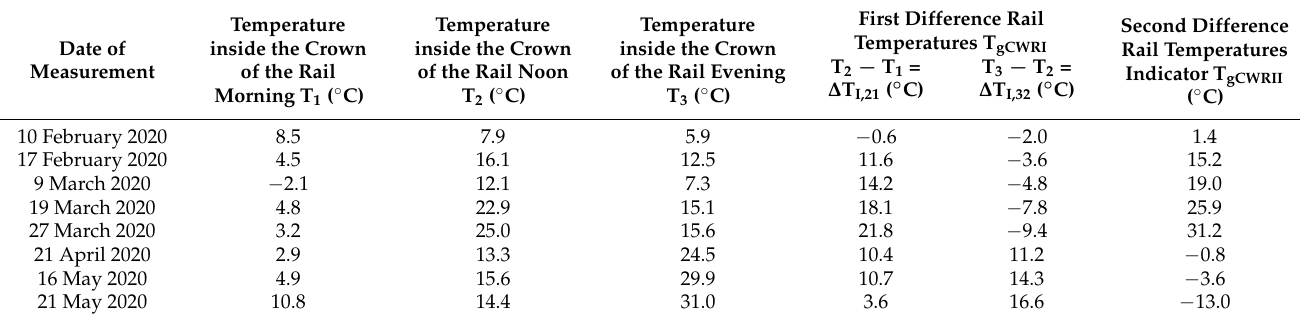
Table 4. S49 (49E1) rail temperature values of the three measurement epochs T 1 , T 2 and T 3 and T gCWRI and T gCWRII calcula- tions.